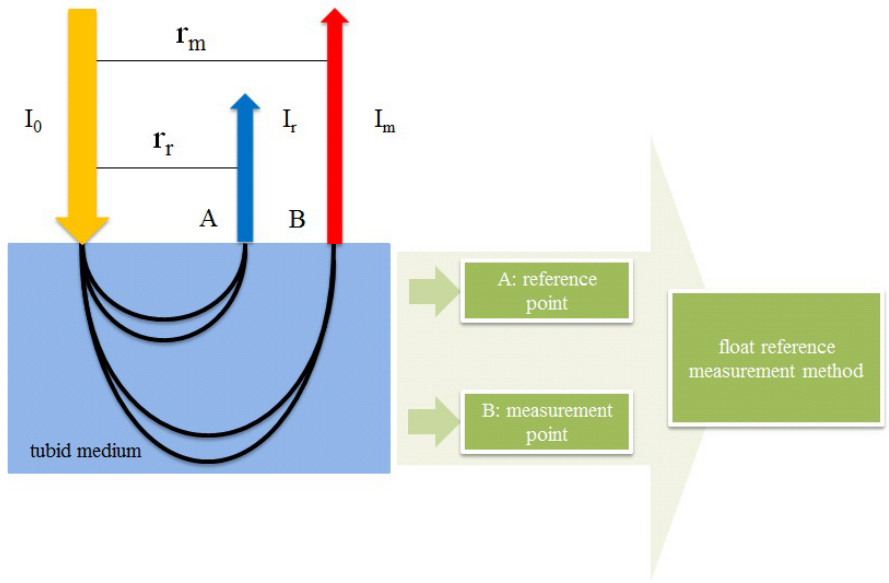
Fig. 4. Principles of °oat reference measurement method.